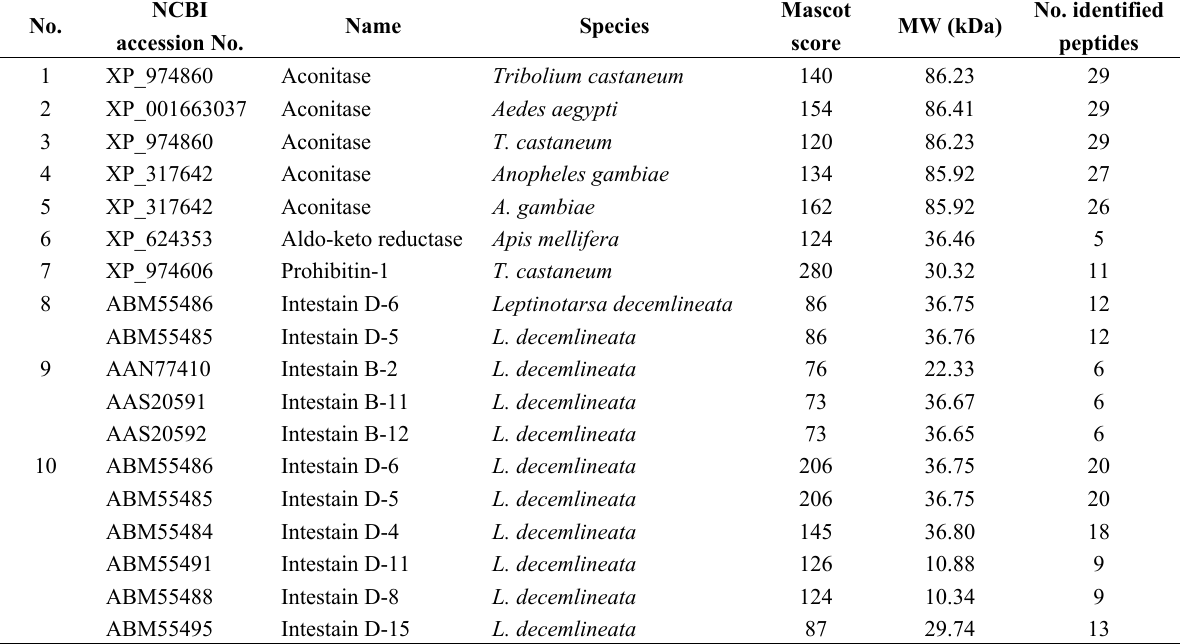
Table 2. Mass Spectrometry analysis of CPB BBMV proteins excised from the Coomassie stained 2D-gel of Figure 2B that gave a positive